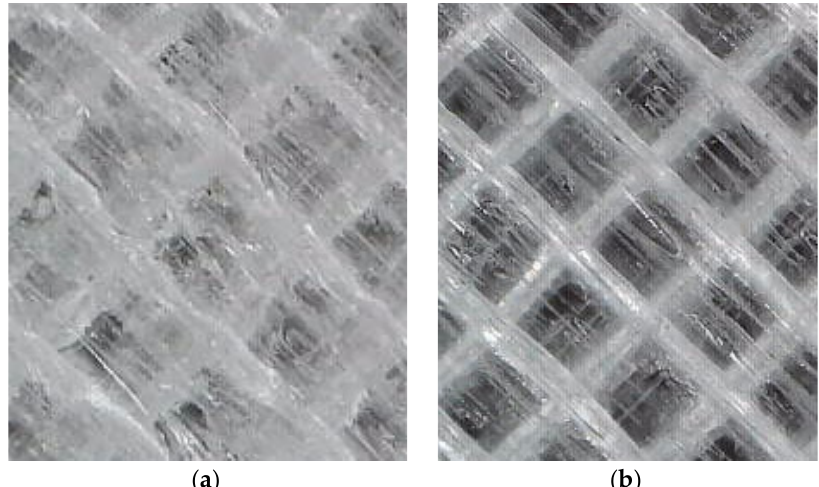
Figure 9. Influence of material moisture on the quality of the surface of the printed samples. (magnification 240×): ( a ) FM—0.41%; ( b ) FM—0.19%.